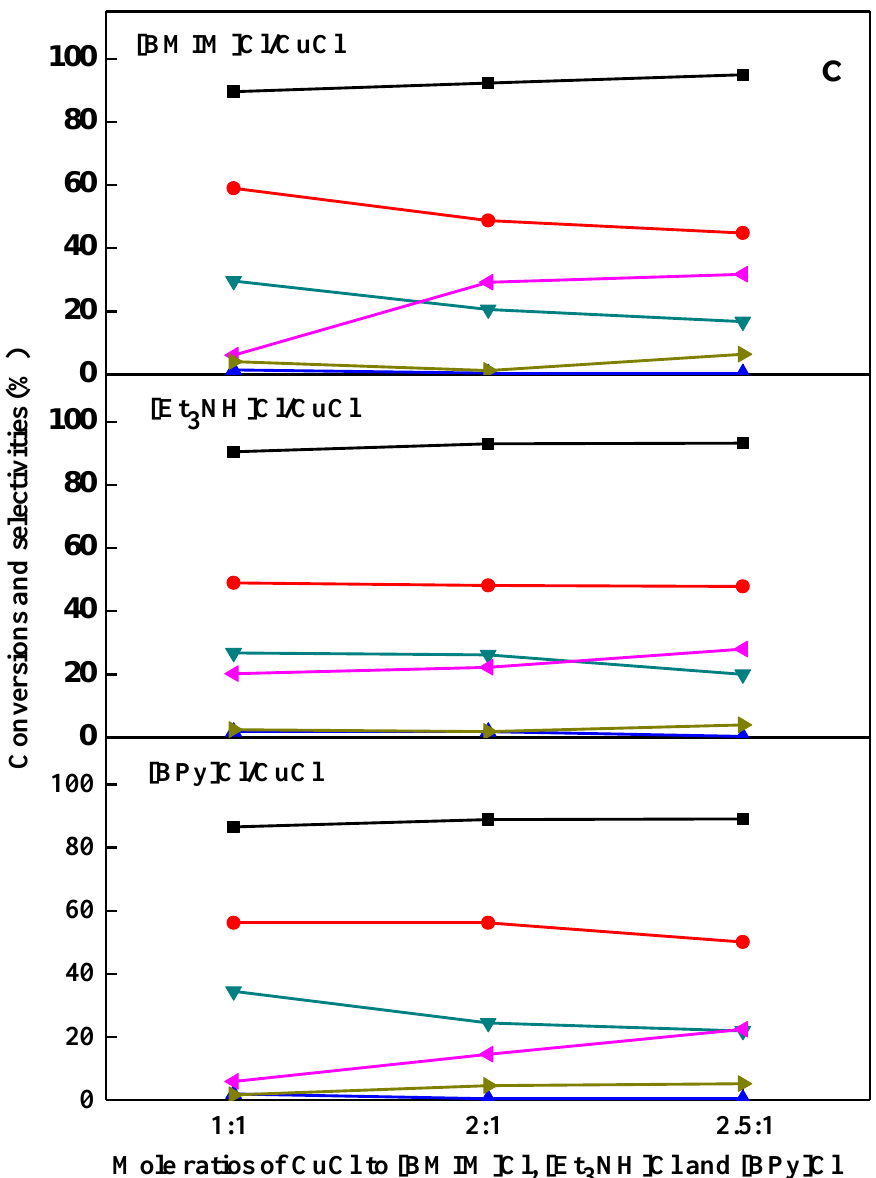
Figure 2. Chlorination of toluene with gaseous Cl 2 over the ionic liquid catalysts , with different mole ratios of ( a ) AlCl 3 , ( b ) ZnCl 2 , and ( c ) CuCl to [BMIM]Cl, [Et 3 NH]Cl, and [BPy]Cl, respectively. ■ , conversion of toluene; ●, selectivity of o -chlorotoluene; ▲ , selectivity of m -chlorotoluene; ▼ , selectivity of p -chlorotoluene; ◄ , selectivity of benzyl chloride; ► , selectivity of dichlorotoluenes. Reaction conditions: toluene, 0.5 mol; chlorine, 25 mL min −1 ; catalyst loading, 3 mol/100 mol toluene; reaction temperature, 80 °C; reaction time, 8 h.